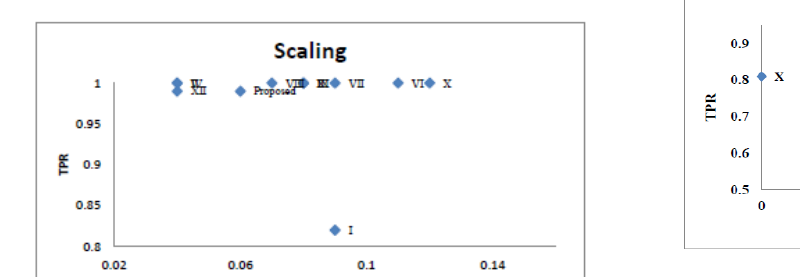
Figure 11. TPR vs. FPR: Increase Brightness.